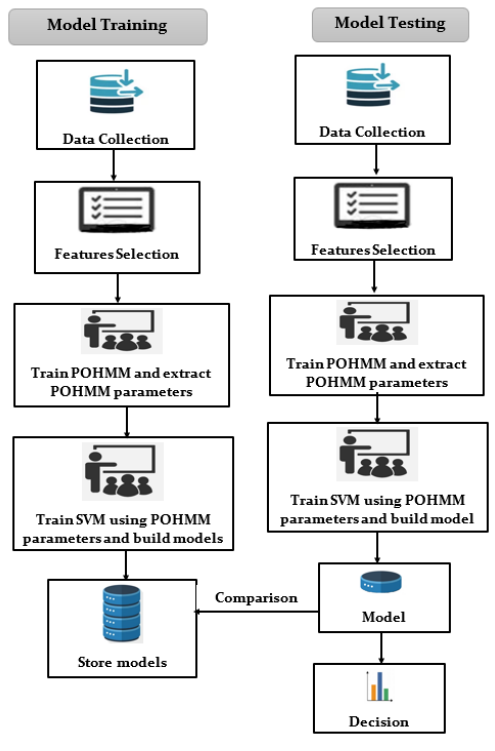
Figure 1. Proposed hybrid POHMM/SVM system overview.